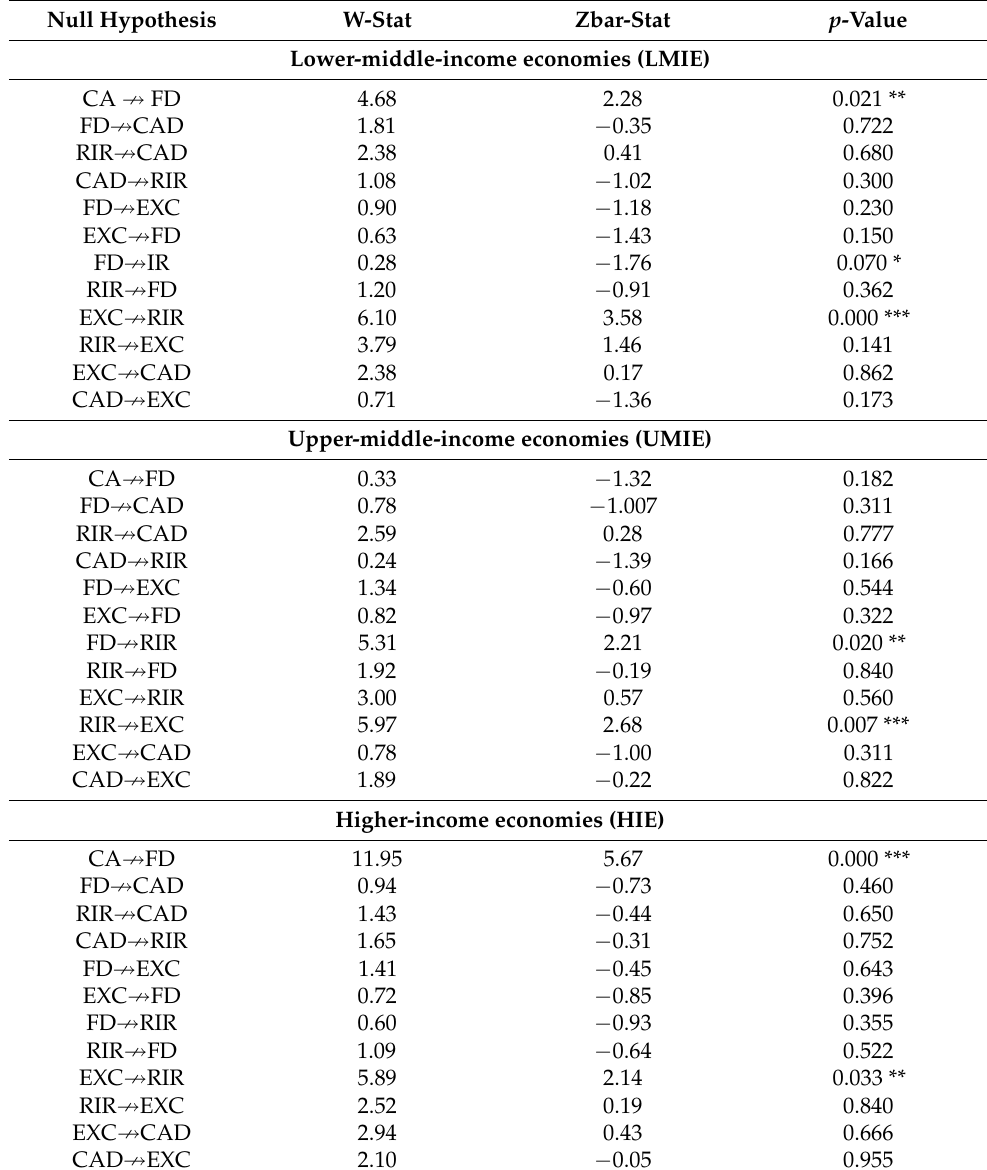
Table 16. Findings of DH Granger causality for three income groups.